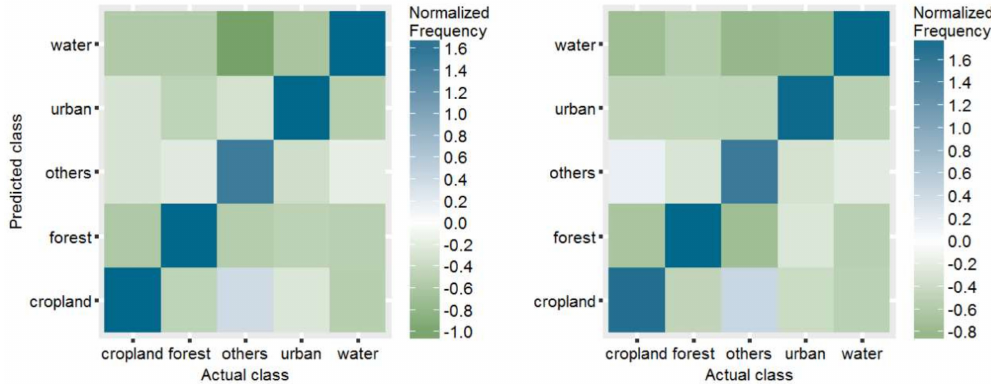
Figure 7. Visual assessment of the stochastic gradient boosting (SGB) classification’s confusion matrix in 2007 (left) and 2016 (right).